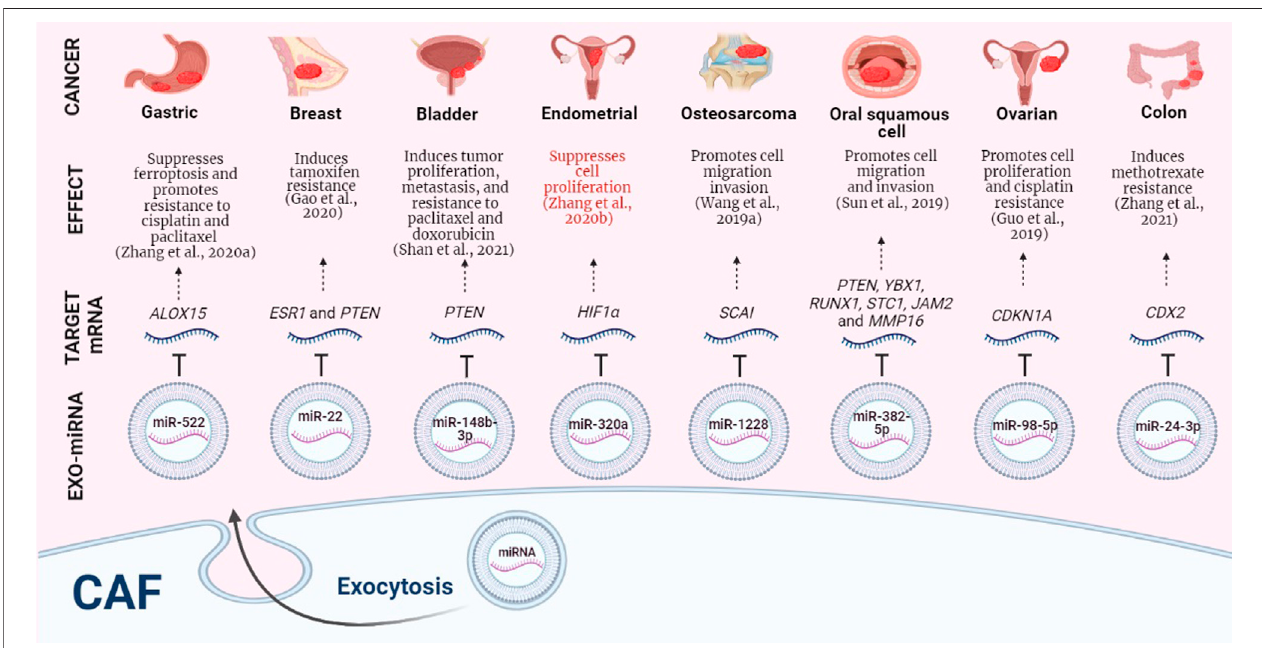
FIGURE 1 | CAFs-derived exosomal miRNAs, their target mRNAs and effects on different neoplasms. Protumoral events in black, antitumor events in red. CAF: Cancer-associated fi broblast. EXO-miRNA: exosomal miRNA. Image created in BioRender.com.